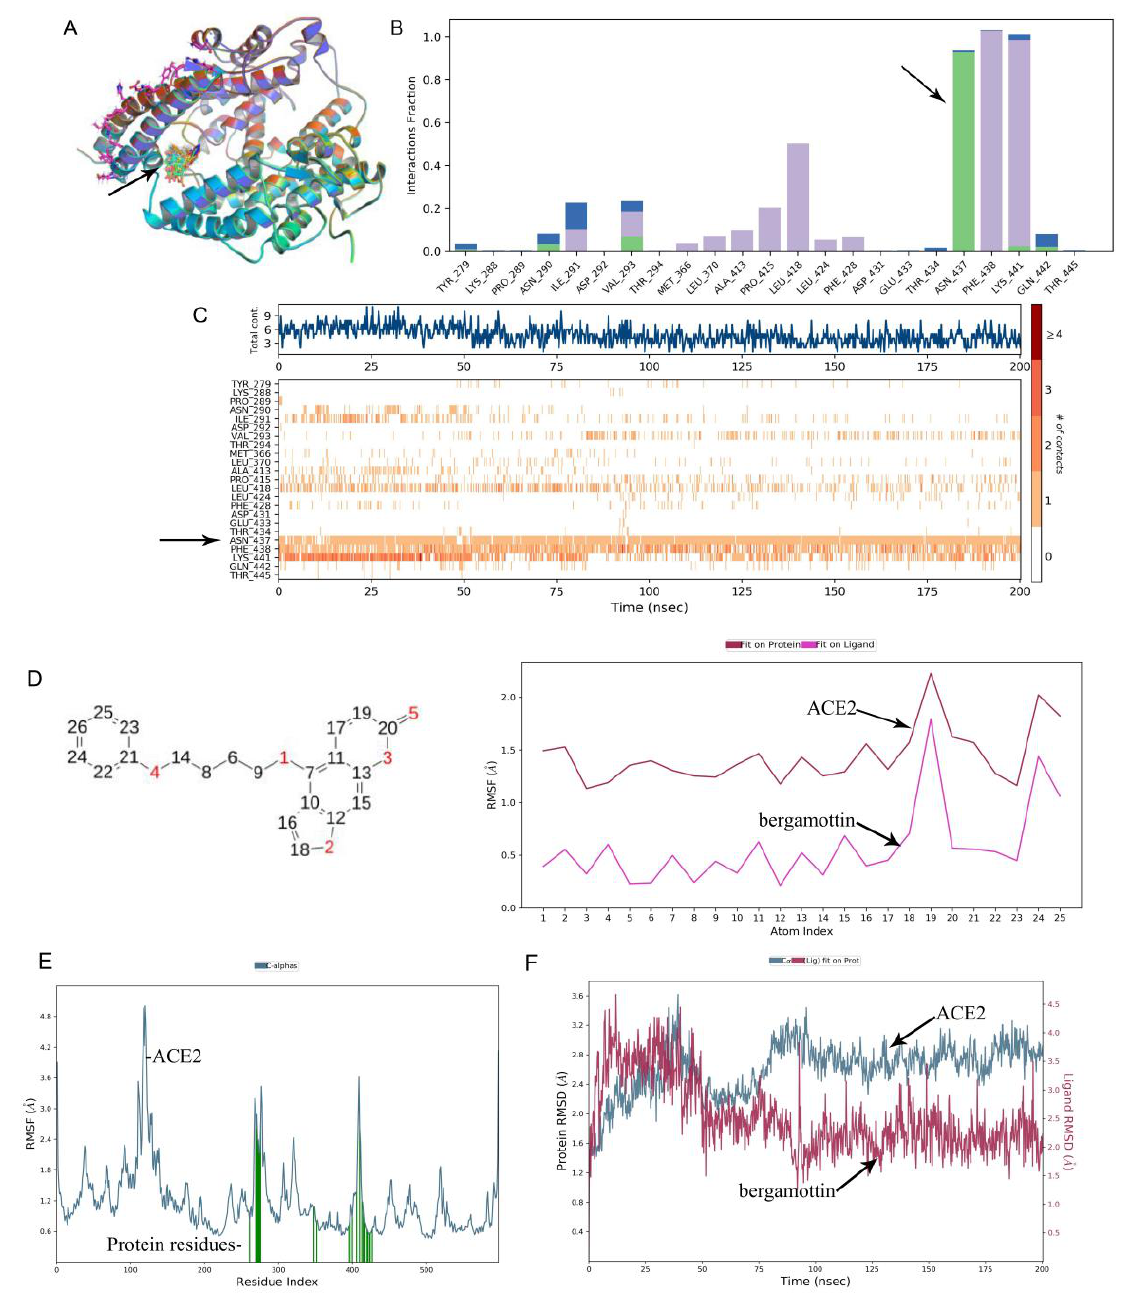
Figure 4. Molecular dynamic simulation analysis of bergamottin and ACE2. ( A ) Molecular docking result mode. The black arrow shows the binding position of ACE2 protein with bergamottin. ( B ) Analysis of interaction between ACE2 protein residue and bergamottin. H-bonds (green part) play a significant role in ligand binding. The black arrow shows that the ACE2 protein has made more than one specific contact with the ASN437 residue in a hydrogen bond. ( C ) Contract number with protein residues. The black arrow shows ASN437 residues make more than one specific contact with the ligand, which is represented by a darker shade of orange, according to the scale to the right of the plot. ( D ) Drug action analysis of RMSF. The black arrow shows the internal atom fluctuations of the bergamottin. ( E ) ACE2 protein RMSF. The black arrow shows ACE2 protein residues that interact with the bergamottin are marked with green-colored vertical bars. ( F ) The interaction of RMSD between ACE2 protein with bergamottin. The black arrow indicates that the observed ligand PAP-1 value is significantly less than the RMSD of protein, indicating that bergamottin did not diffuse from its initial binding